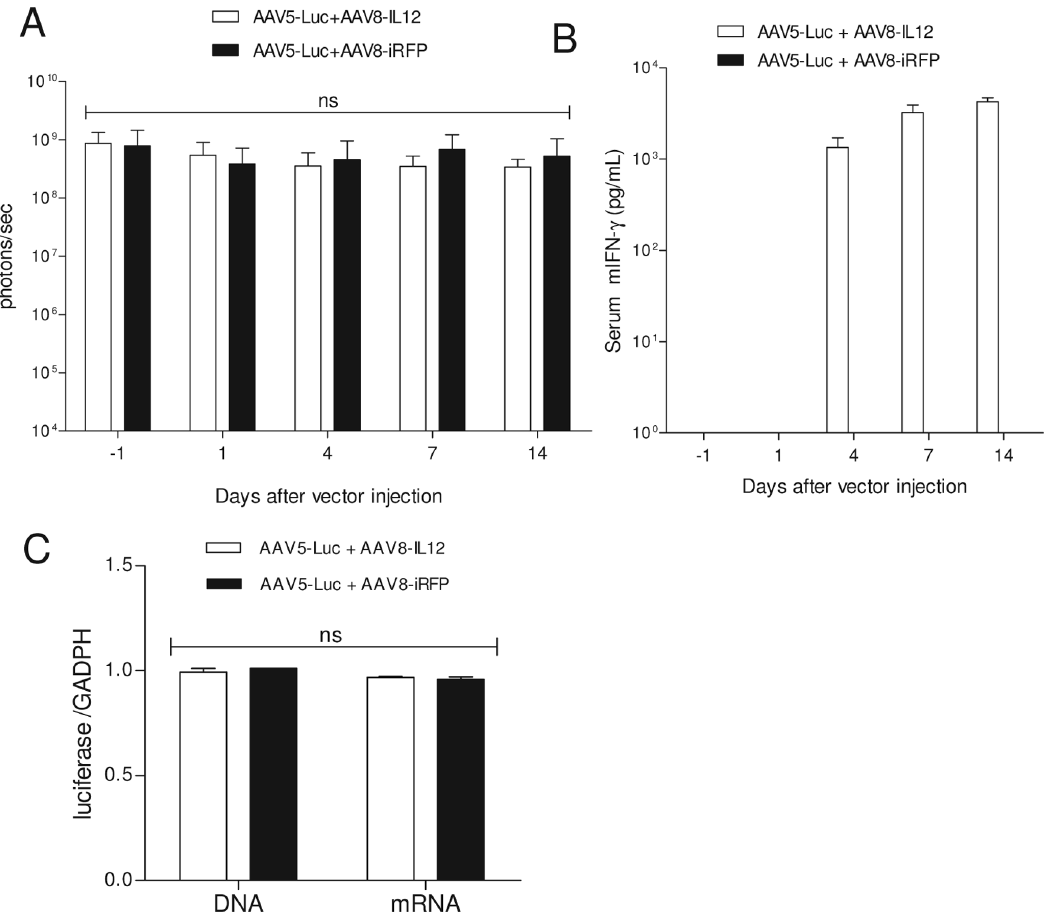
Figure 6. IL-12 has no effect over AAV-mediated stable expression. A) C57BL6 were intravenously injected with an AAV5-luc vector at a dose of 2.5 6 1013 vg/kg, 21 days later luciferase expression was measured (day 2 1) and one day (day 0) later animals (n=5) received an intravenous injection of AAV8-IL12 or AAV8-iRFP at a dose of 1.5 6 109 vg/kg. Luciferase expression levels were analyzed in both groups of animals at days 1, 4, 7, and 14 using a Xenogen in vivo luminometer. Luciferase expression was quantified and represented as photons/second. The data are shown as mean 6 standard deviation (SD). The differences in luciferase expression were statistically evaluated by Student t test (ns, not significant). B) IFN- c expression levels in serum were analyzed by ELISA at days 1, 4, 7 and 14. C) Animals were sacrificed 14 days after AAV8-IL12 and AAV8-iRFP injection. Total DNA and RNA were isolated from liver and vector genome copies and luciferase messenger RNA (mRNA) copies were determined using a q-PCR specific to luciferase, normalized to GADPH copy numbers. Values corresponding to the mean copy number from five